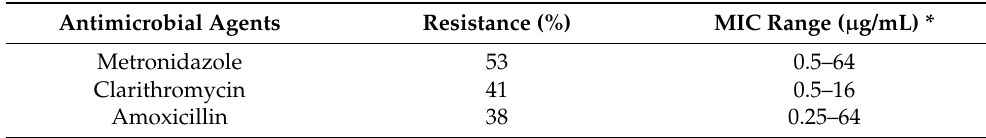
Table 3. Susceptibility of H. pylori isolates to common therapeutic antimicrobials.